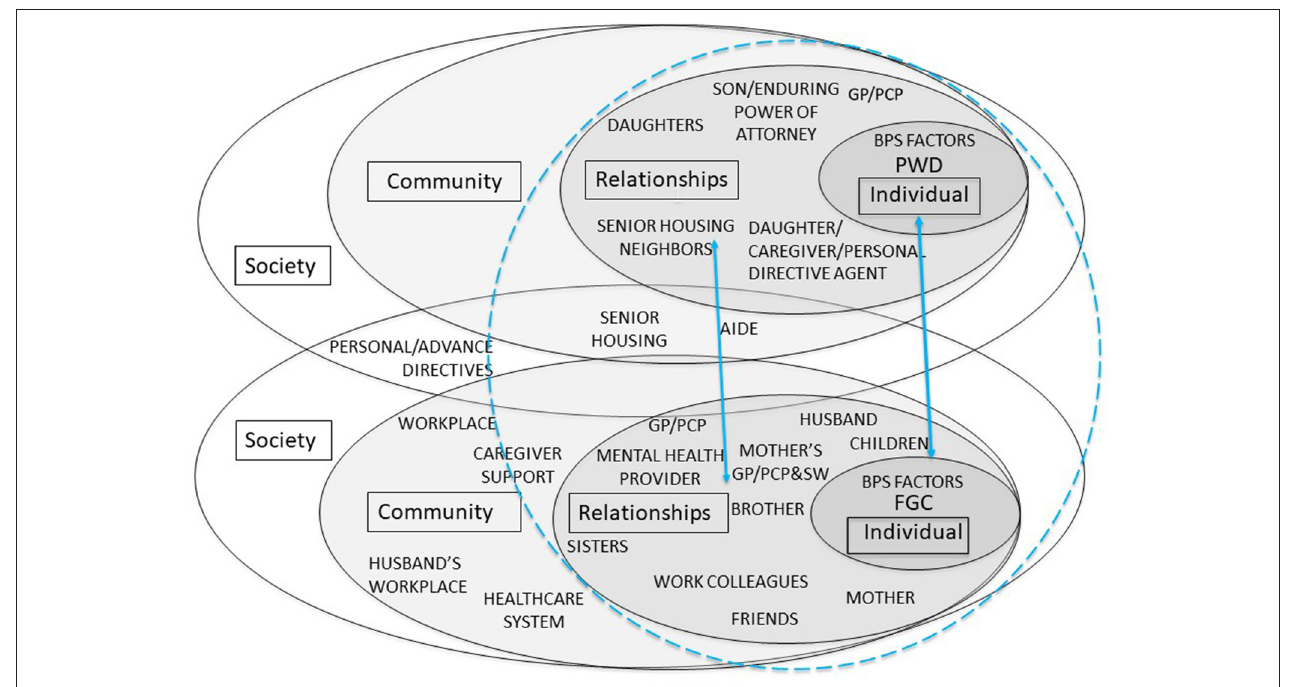
FIGURE 3 | Biopsychosocial-Ecological Family-Framed Approach to Dementia